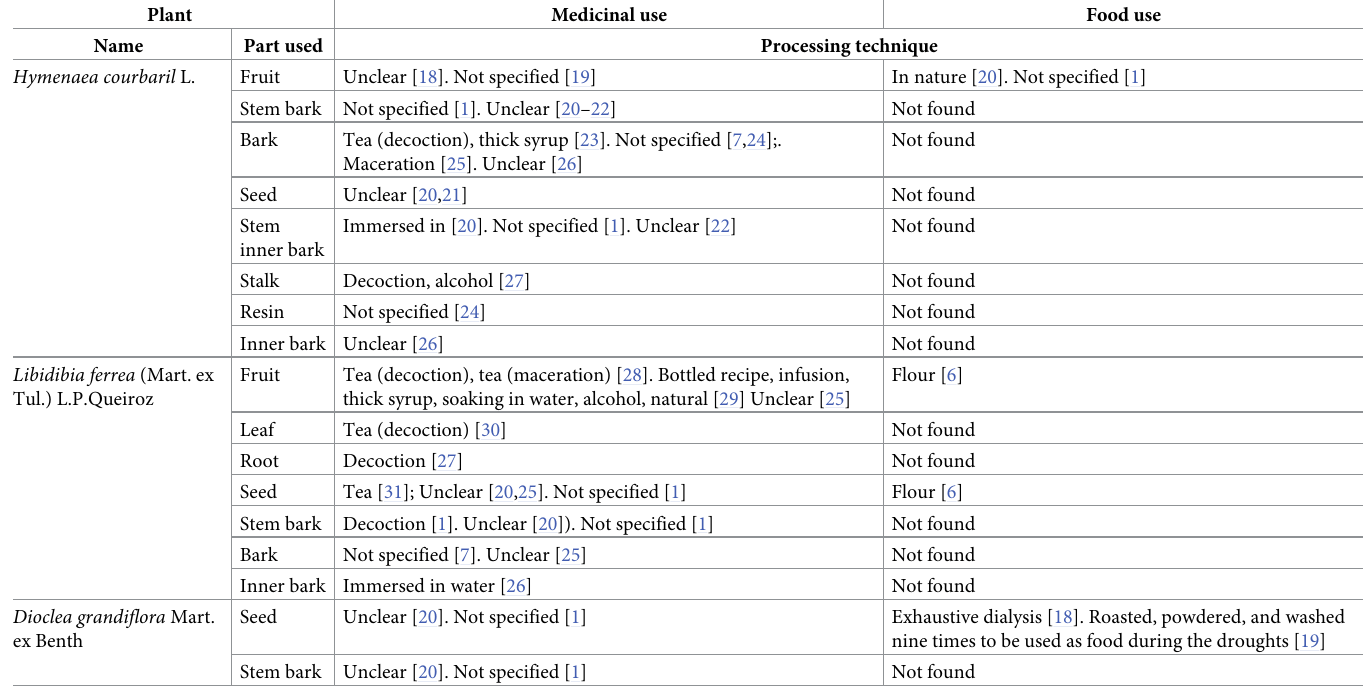
Table 1. Synthesis of processing techniques applied to tree legumes before oral intake.